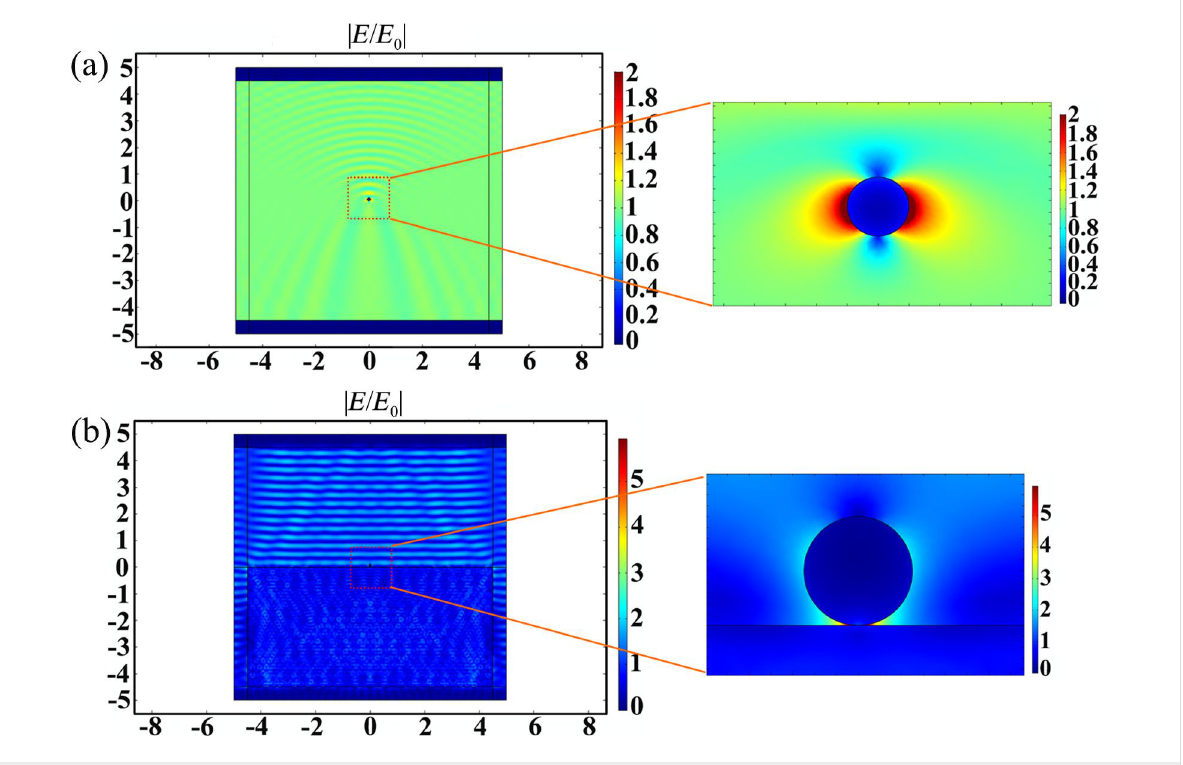
Figure 9: (a) Electric field distribution in the air of a Ag nanoparticle with radius of 100 nm. (b) Electric field distribution of a Ag nanoparticle with radius of 100 nm on the substrate.